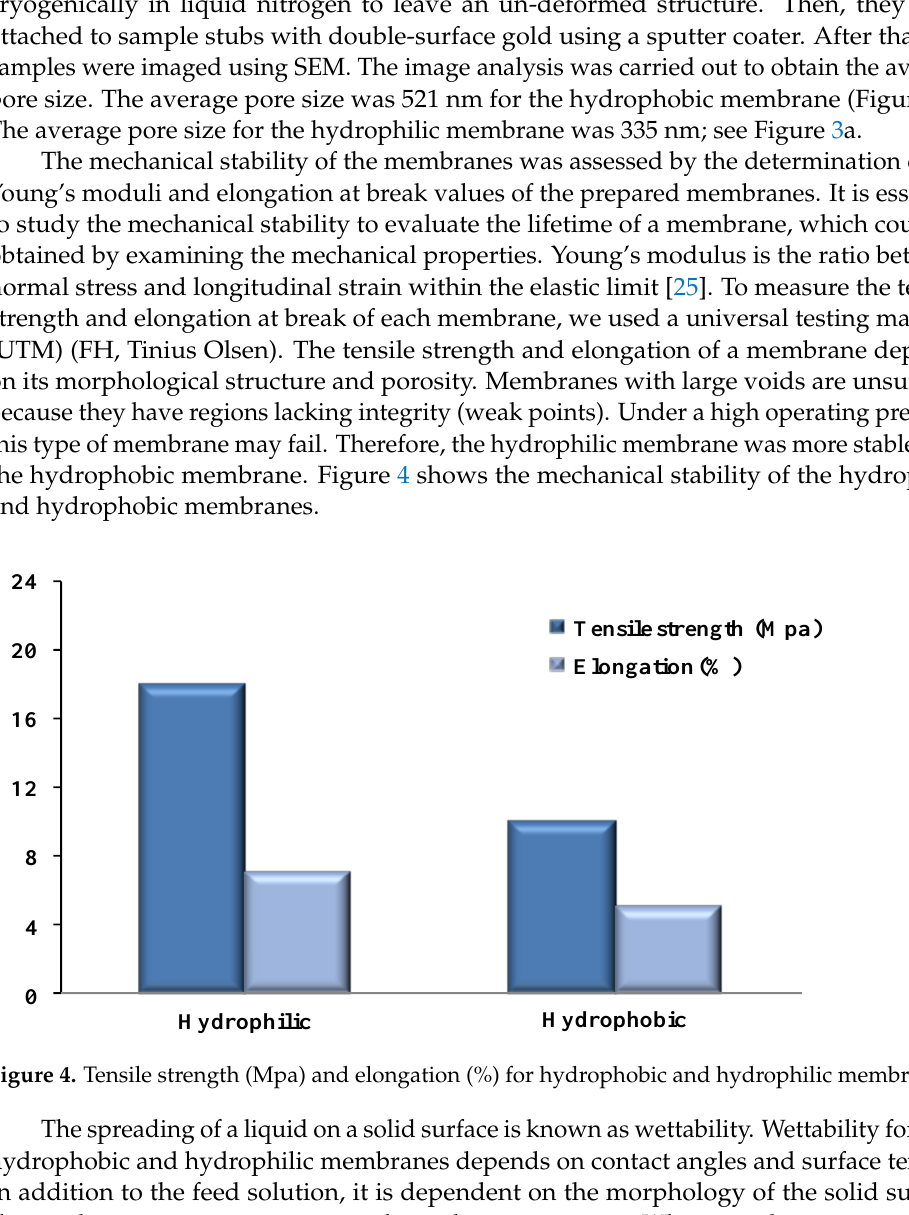
Figure 3. SEM images: ( a ) top surface of the hydrophilic membrane and ( b ) cross-section of the hydrophilic membrane.